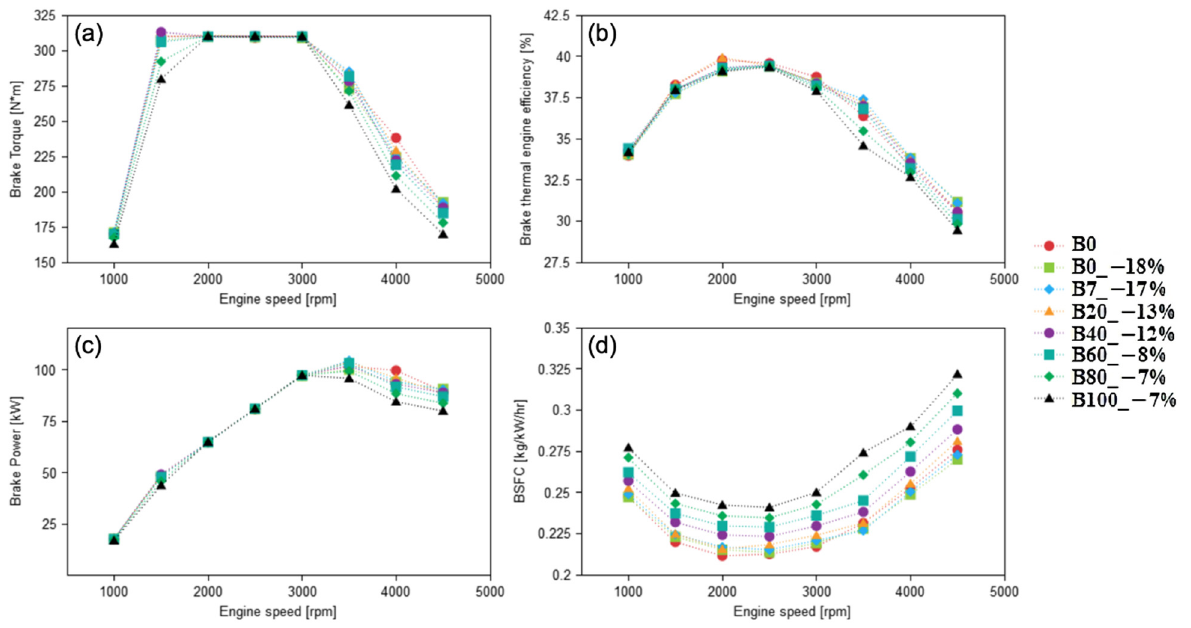
Figure 11. Comparison of ( a ) brake torque, ( b ) BTE, ( c ) brake power and ( d ) BSFC, for different optimal setups.